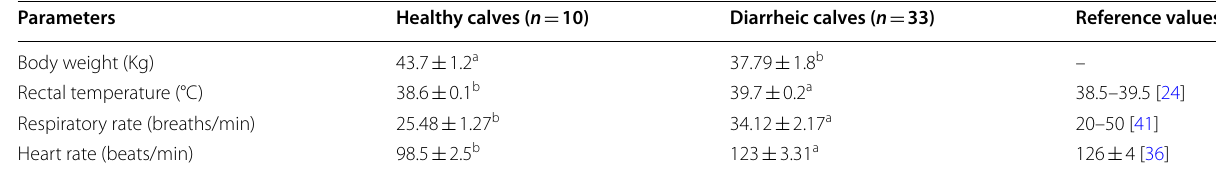
Table 2 Clinical examination parameters in diarrheic and healthy calves included in the present study